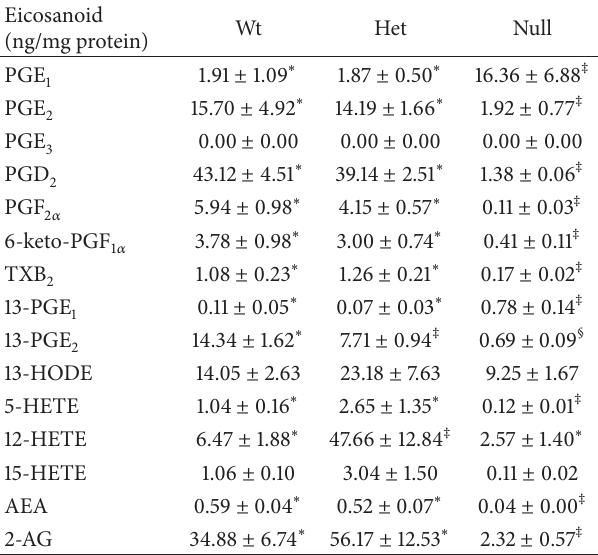
Table 2: Colonic mucosal eicosanoid and cannabinoid profiles in Fads1 TNBS-treated mice 1